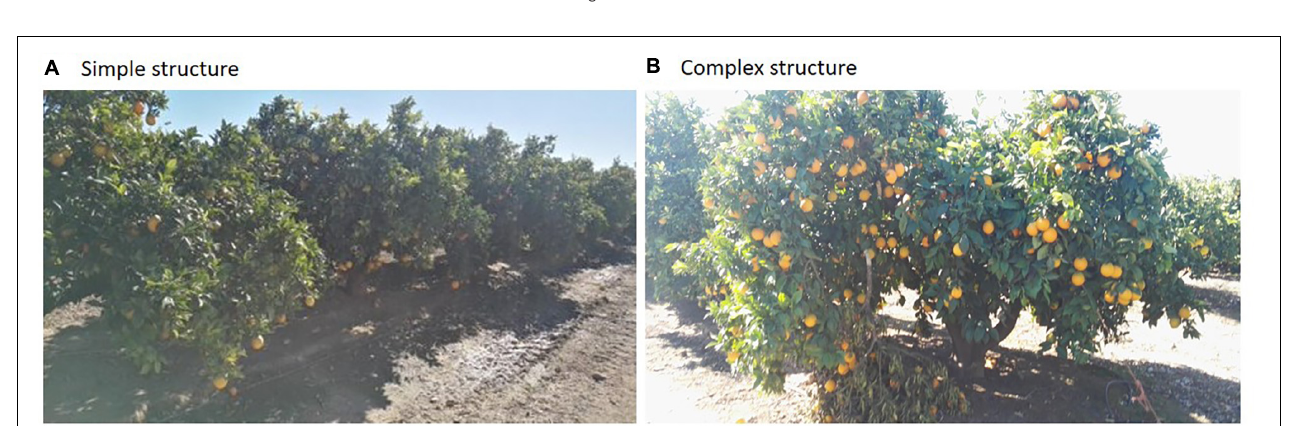
FIGURE 8 | Simple and complex structures of mango